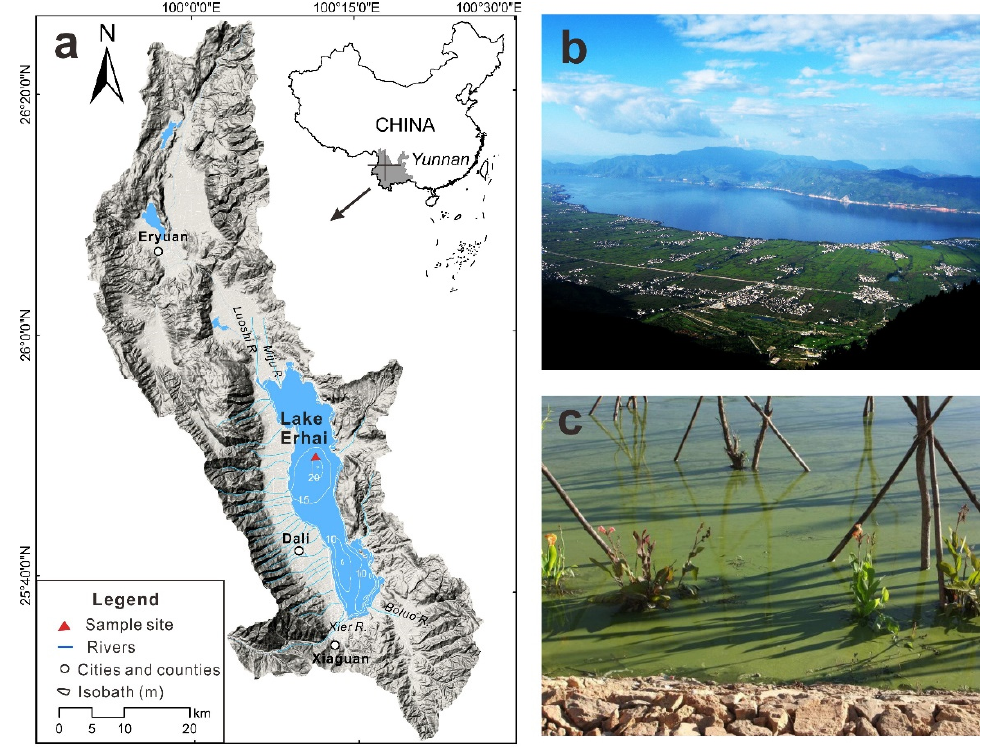
Figure 1. Erhai, Yunnan Province, China. ( a ) Lake location and its catchment showing lake outflow, water depths (5 m intervals) and the main core location (red dot), that provided the paleolimnological data [9]. ( b ) Photograph from western mountains looking across the deepest and widest part of the lake